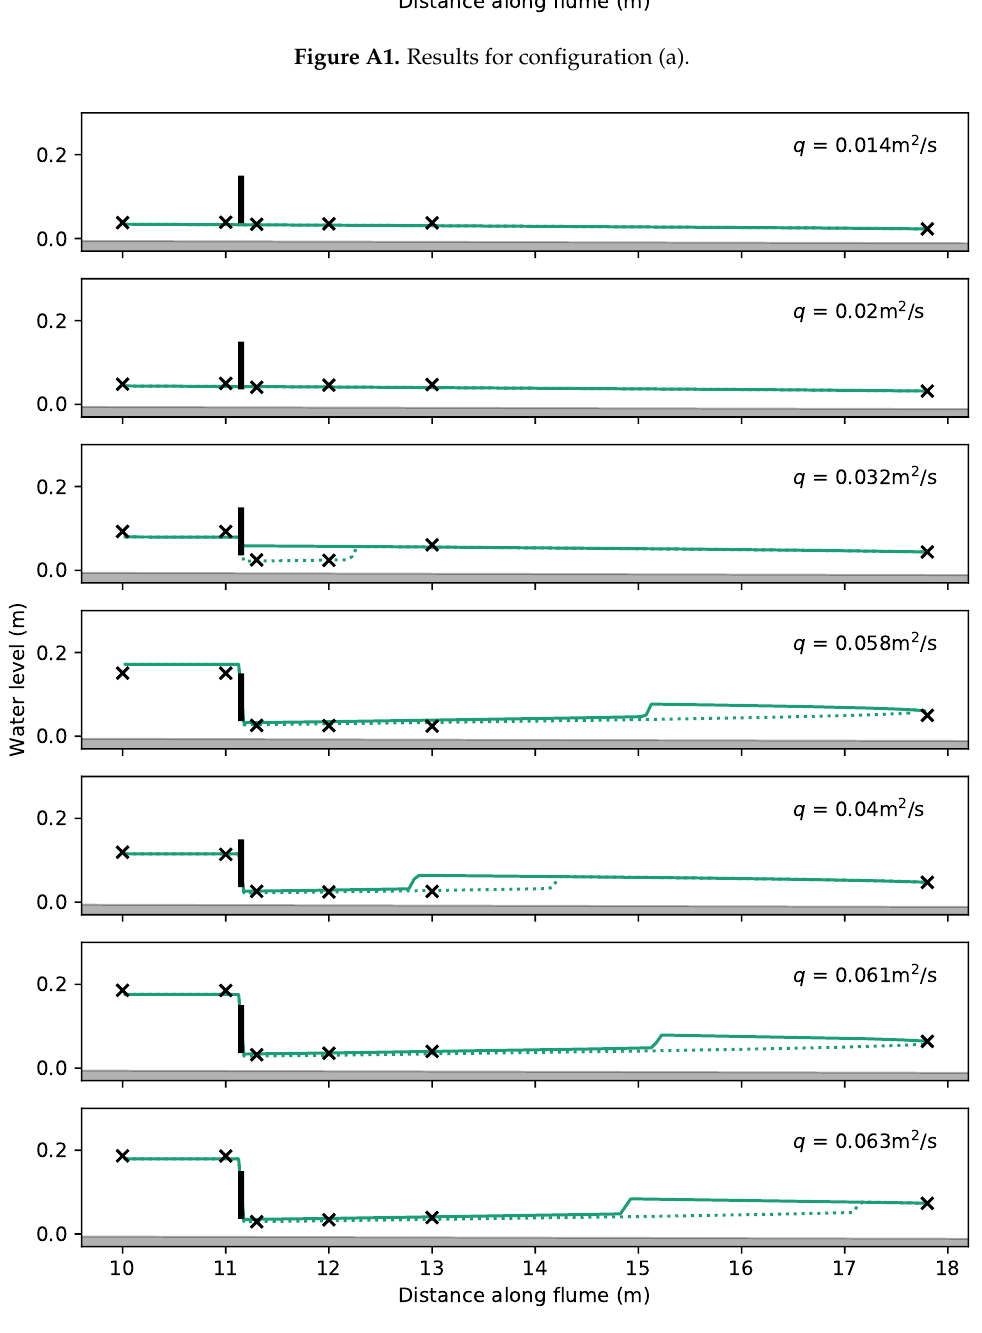
Figure A2. Results for configuration